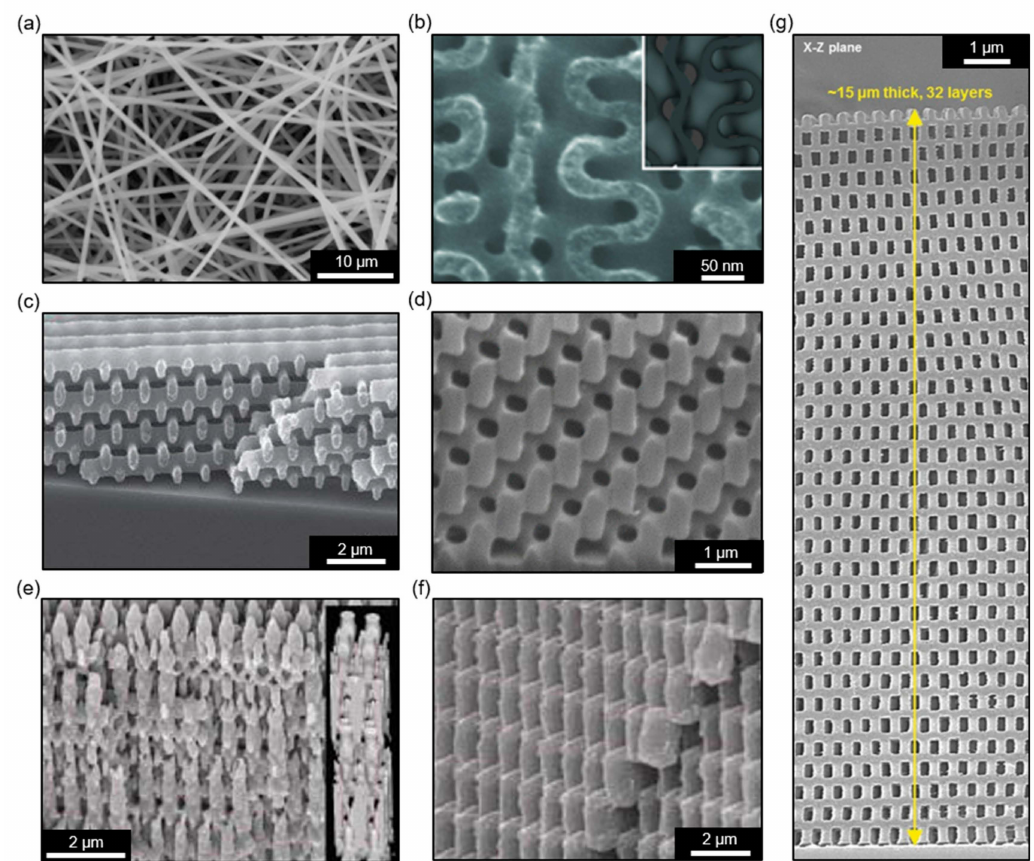
Figure 3. SEM images of polymer templates with irregular or regular 3D nanonetwork